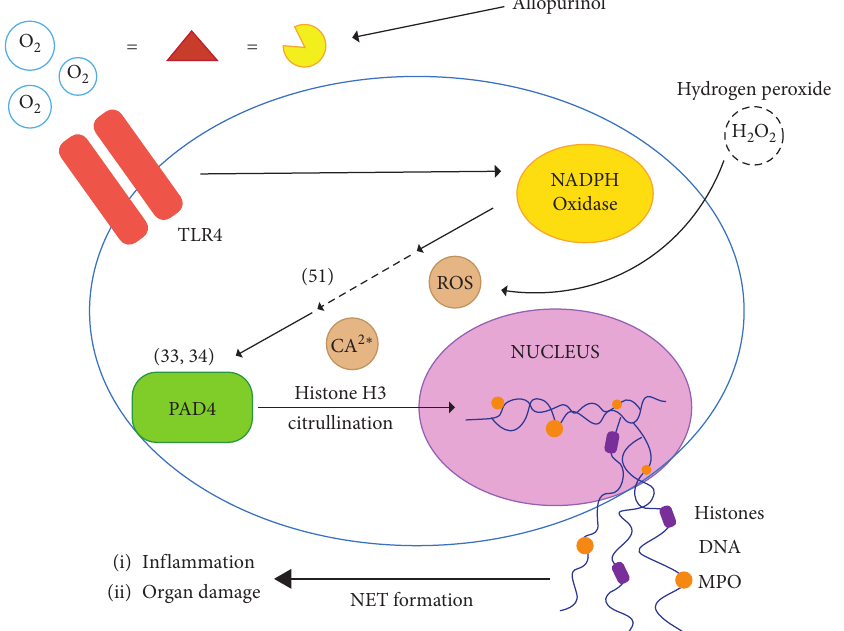
Figure 4: Allopurinol suppressed NETosis formations in vitro. XO activity triggered NETosis in vitro while administration of allopurinol inhibits NETosis. The figure was adapted from Khafarijiy et al.